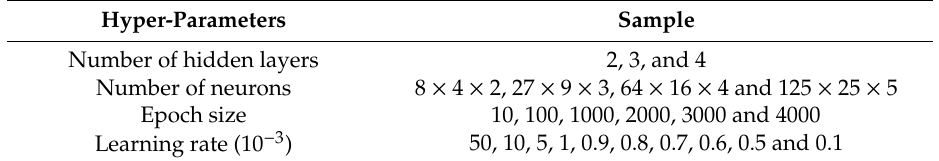
Table 5. Subject to trade ‐ off studies for defining hyperparameters for pipelines with a dent.